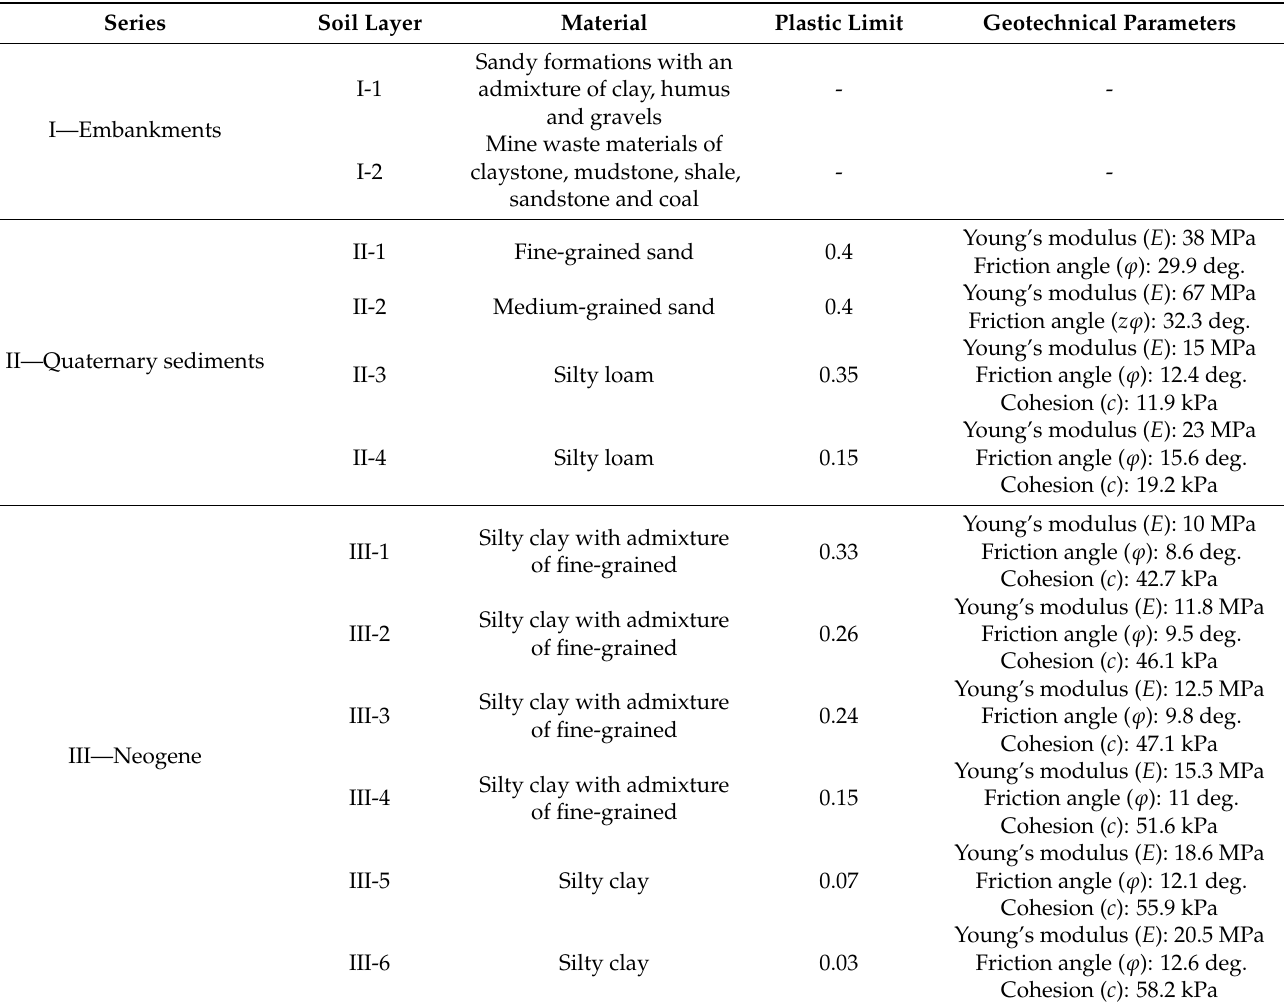
Table 2. Geotechnical characteristics of soils at the studied site (the Janina mine waste dump)